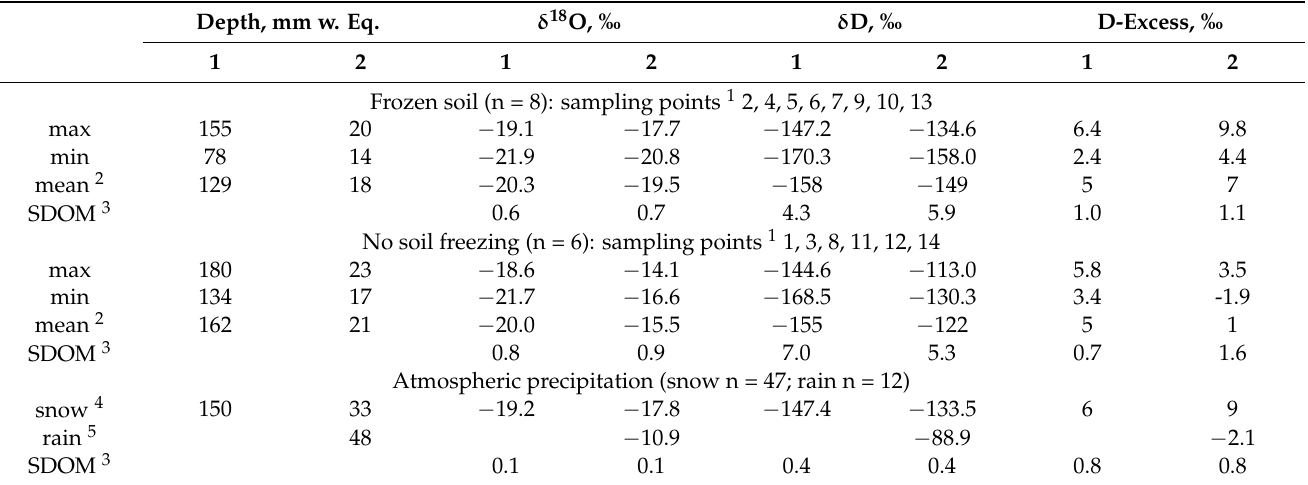
1 number according to Figure 1b; 2 arithmetic mean for the depth; depth-weighted mean for δ 18 O, δ D, d-excess; 3 SDOM—standard deviation of the mean; 4 precipitation-weighted mean for the same period as the snowpack layers; 5 precipitation-weighted for the last two months before snow